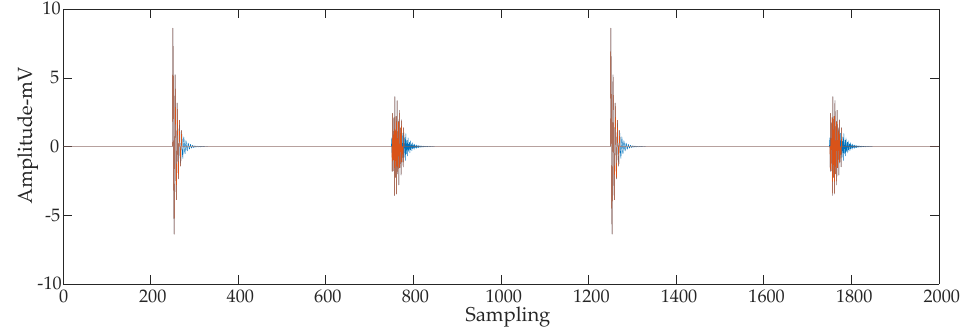
Figure 13. White noise interference suppression achieved by the IEMD method.